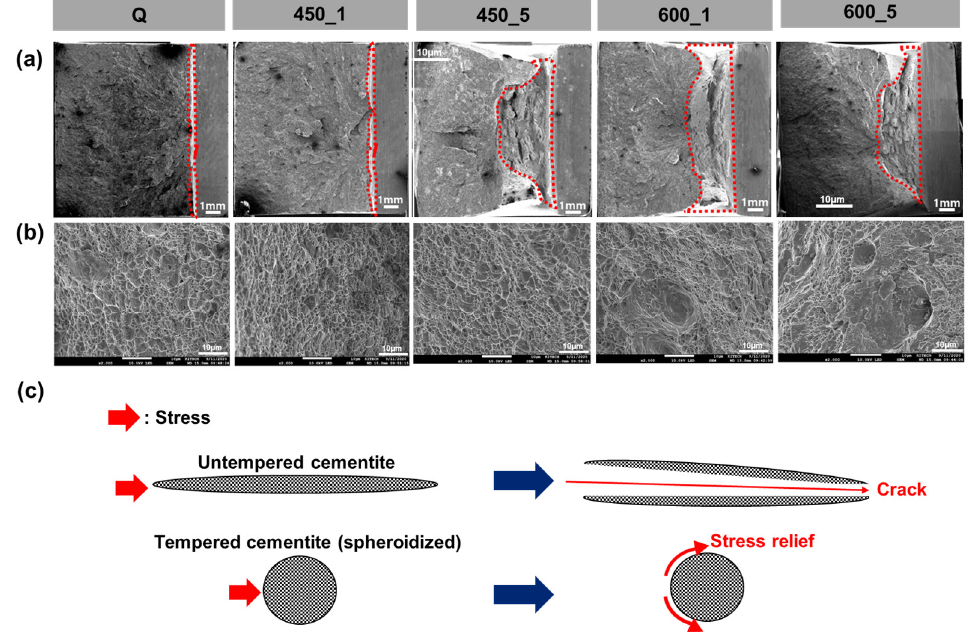
Figure 12. ( a ) Increased ductile-fractured surface (inside red lines) with tempering, ( b ) dimpled surface, ( c ) schematic illustration of stress relief on spheroidized carbides.